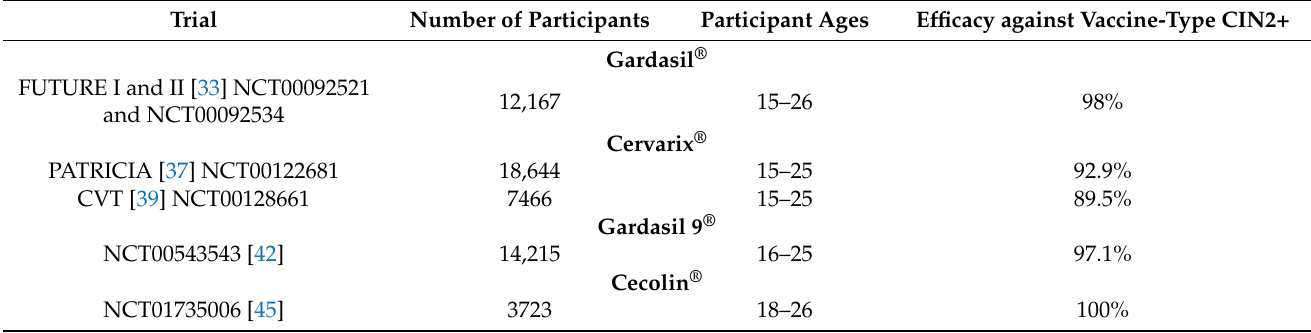
Table 2. Summary of prelicensure trials on HPV vaccine efficacy in younger